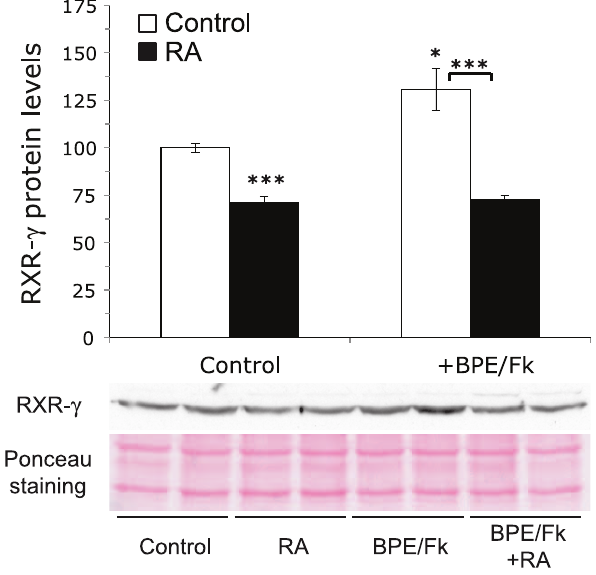
Figure 9. Retinoic acid and axonal contact mimickers regulate RXR- c protein levels. Isolated SCs were adapted for 24 hours to the absence of the axonal contact mimickers BPE and forskolin and subsequently treated for 48 hours with 1 m M RA in the presence or absence of 2 m M forskolin and 60 m g/ml BPE, and the protein levels of RXR- c were analyzed by western blot. The upper panel depicts the quantitation of the blots. The data are presented as the mean value 6 SEM referred as the percentage over the controls. Significance was assessed by unpaired Student’s t -test. *: p , 0.05; ***: p , 0.005.